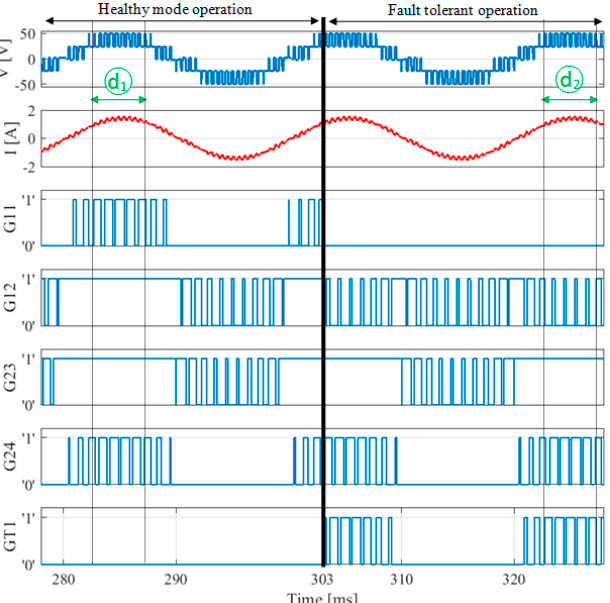
Figure 8. Detailed representation of the fault-tolerant operation in the case of an open-circuit fault occurrence in S 11 . occurrence in S 11